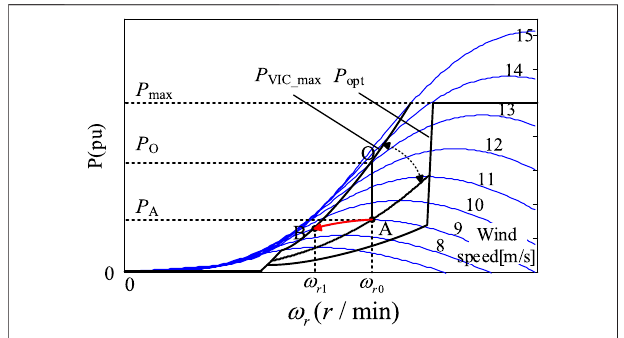
FIGURE 4 | Schematic diagram of power tracking curve switching of virtual